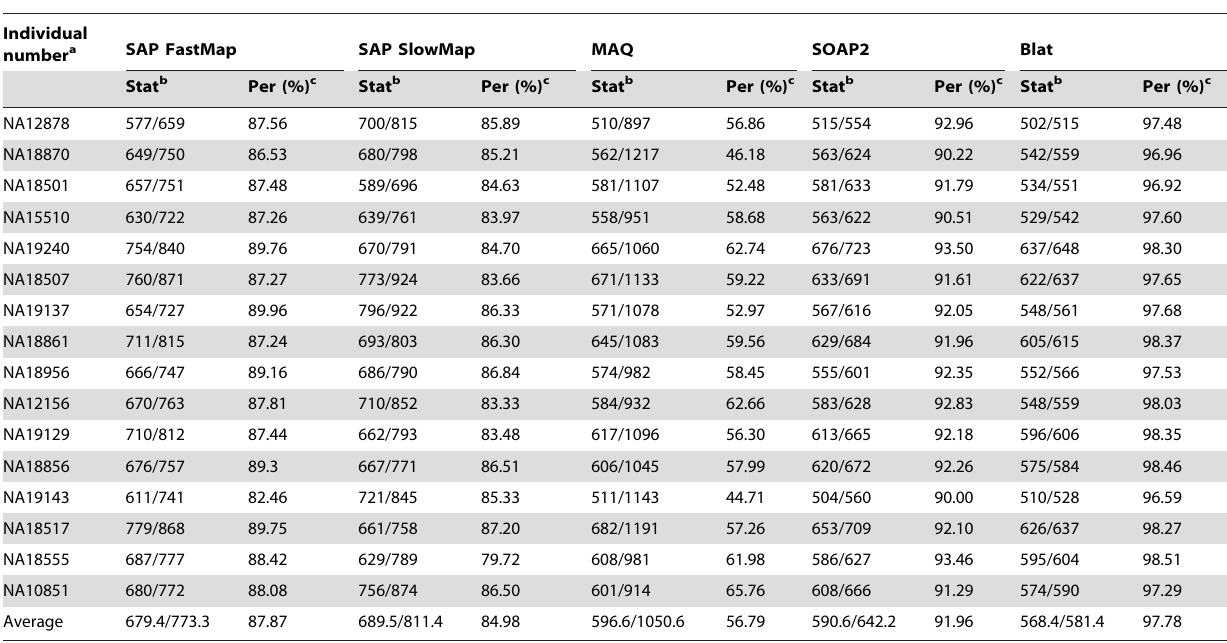
Table 4. Performance of different algorithms on detecting SNPs in real data.